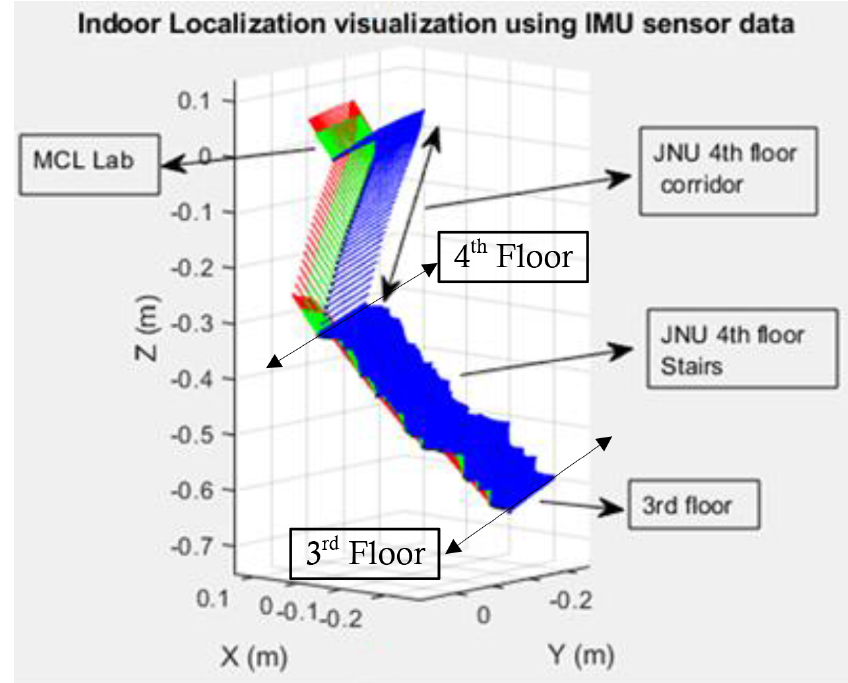
Figure 11. Indoor localization visualization using IMU sensor data.